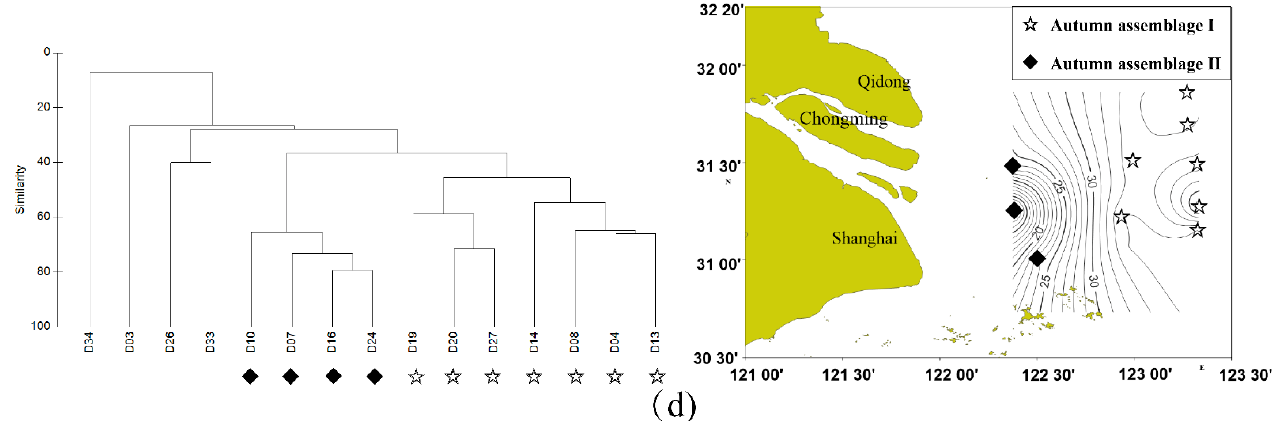
Figure 4. Fish assemblage structure, Yangtze Estuary, 2018: ( a ) winter, ( b ) spring, ( c ) summer, ( d ) autumn.